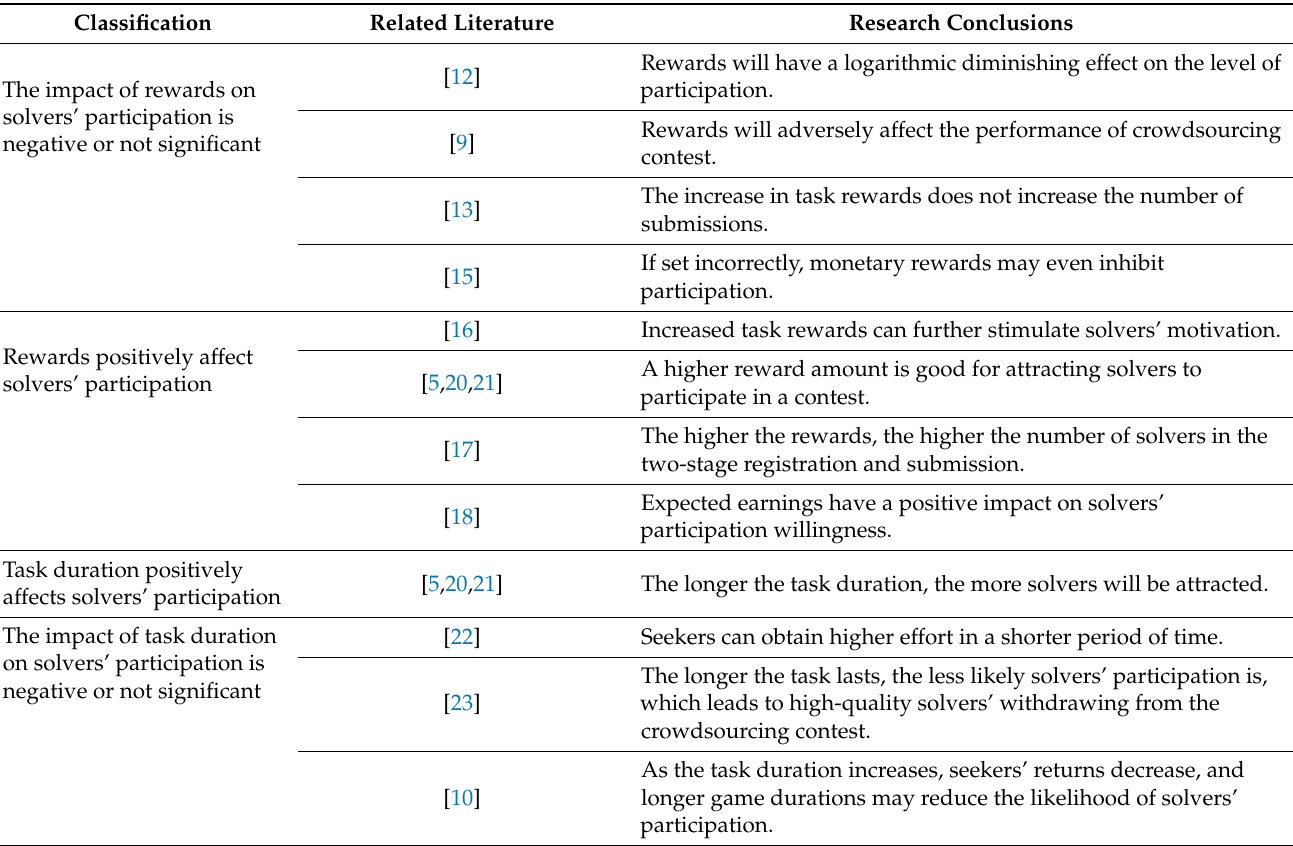
Table 1. Summary of findings of related